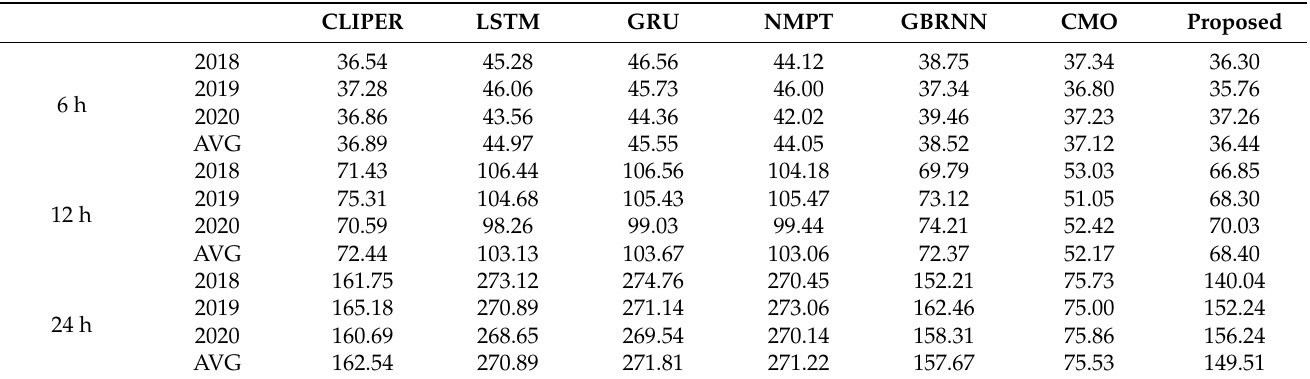
Table 10. Six-, twelve-, and twenty-four-hour distance error of traditional and deep learning methods (km).